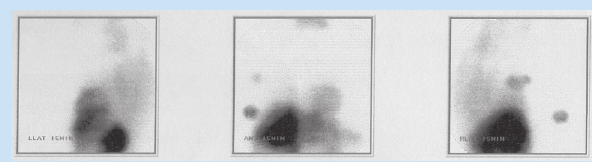
Fig. 3. Anterior and right lateral SM shows a single area of increased abnormal uptake in the right breast and also focal uptake in the right axilla of a 34-year-old patient.